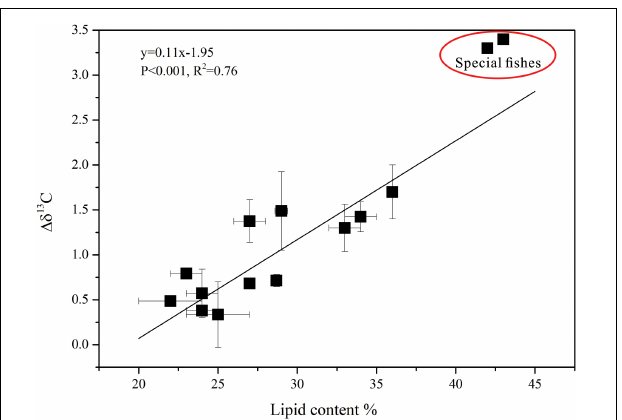
FIGURE 4 | The relationship between (cid:49) δ 13 C ( δ 13 C extraction – δ 13 C bulk ) and lipid content in all fish groups (special fishes: M. bericoides of group 3 and S. nebulosus of group 5 in breeding mode).